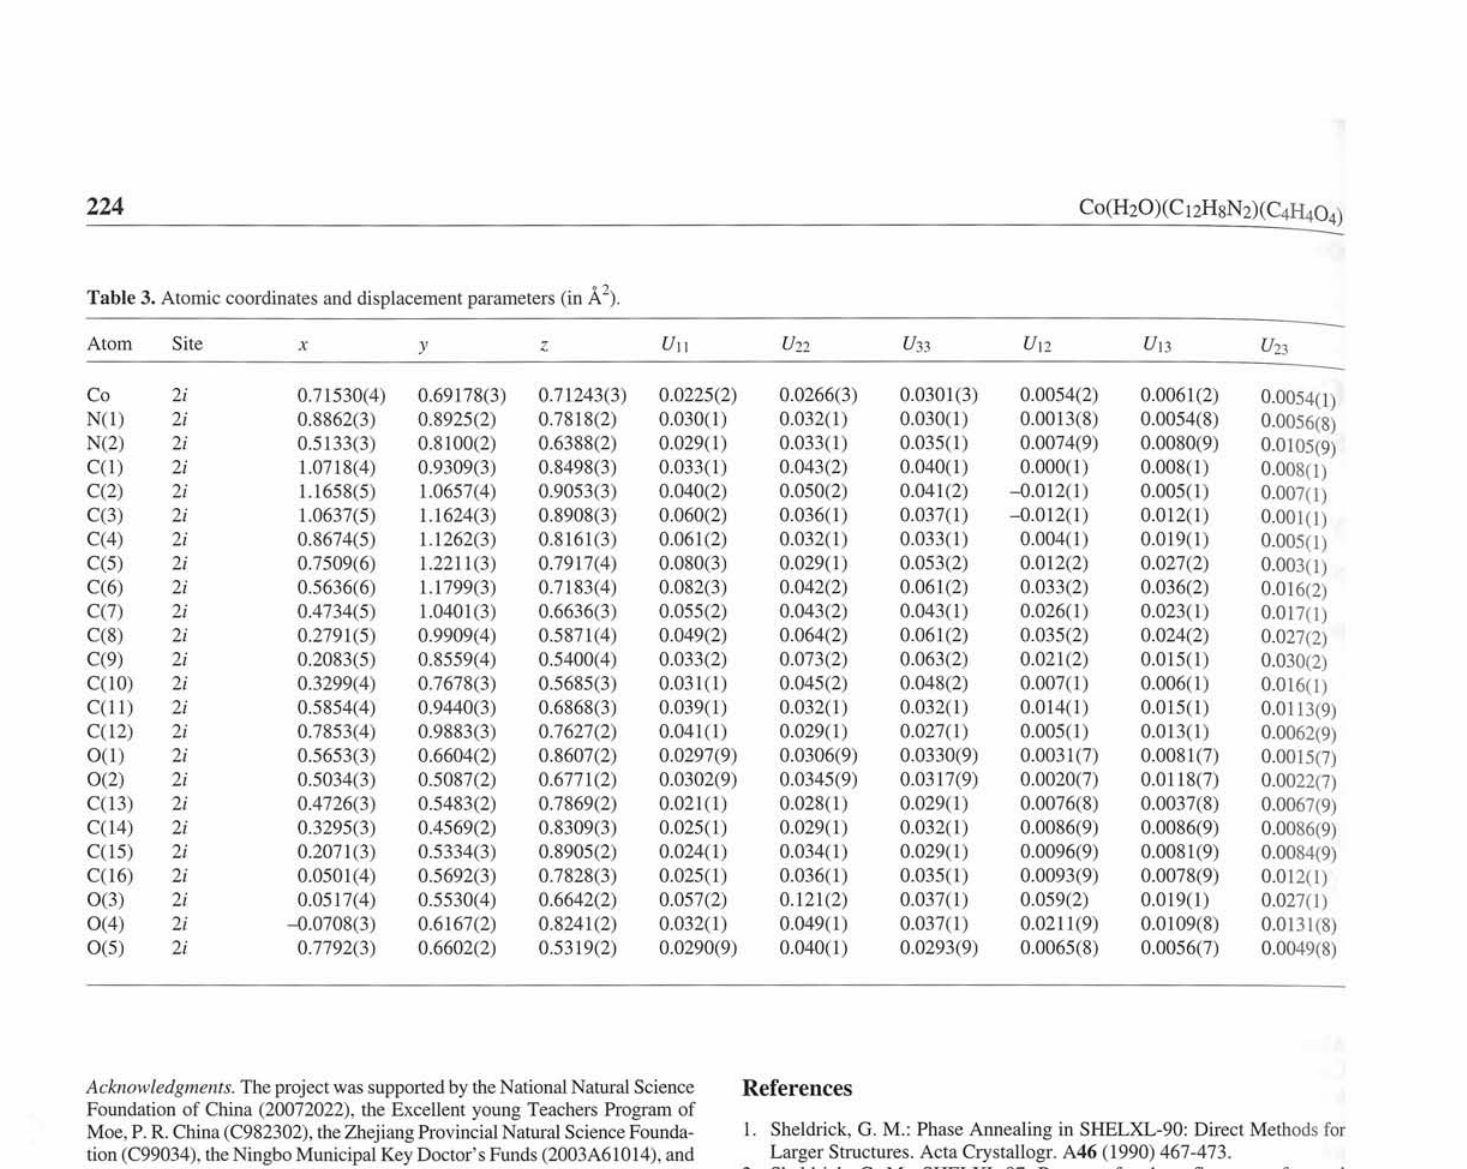
Table 3. Atomic coordinates and displacement parameters (in Á 7